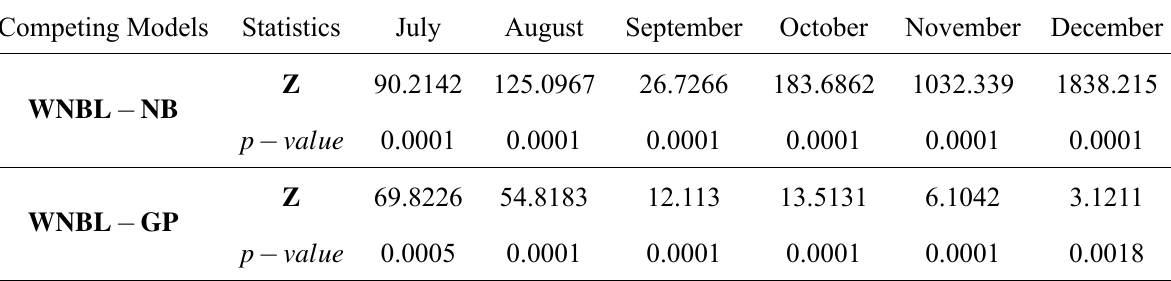
Comparison via Vuong